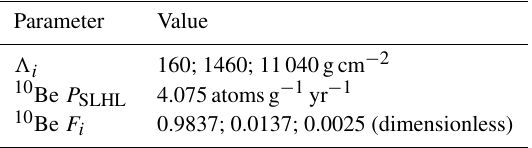
Table 4. Parameters used for production of 10 Be which approxi- mate the scheme in CRONUScalc (Marrero et al., 2016). λ ues are the same as defaults listed previously. The F i values repre- sent spallation and fast and slow muons,